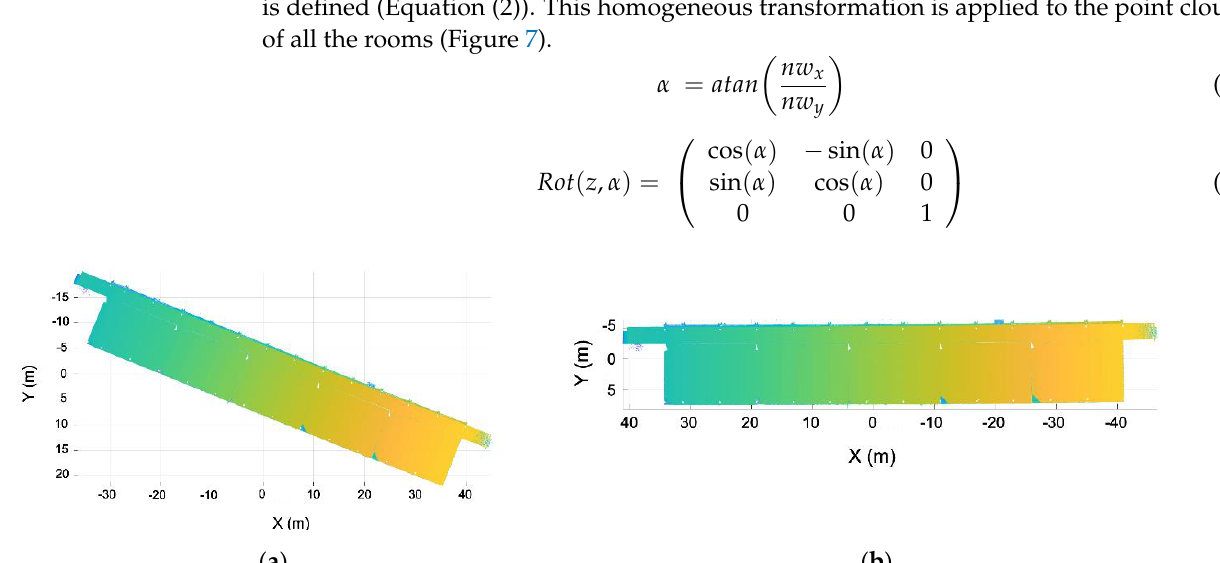
Figure 7. Point cloud alignment with the X and Y axes. ( a ) Point cloud before the alignment. ( b ) Point cloud after the alignment.